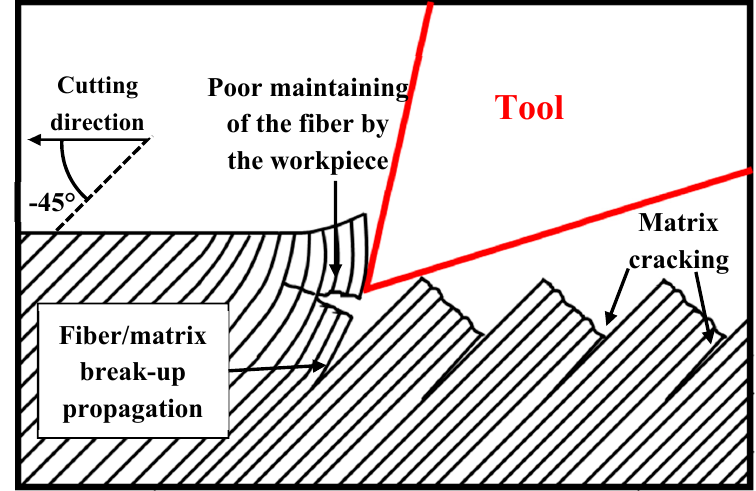
Figure 1. Cutting mechanism of fiber reinforced polymer (FRP) with an − 45° fiber orientation.